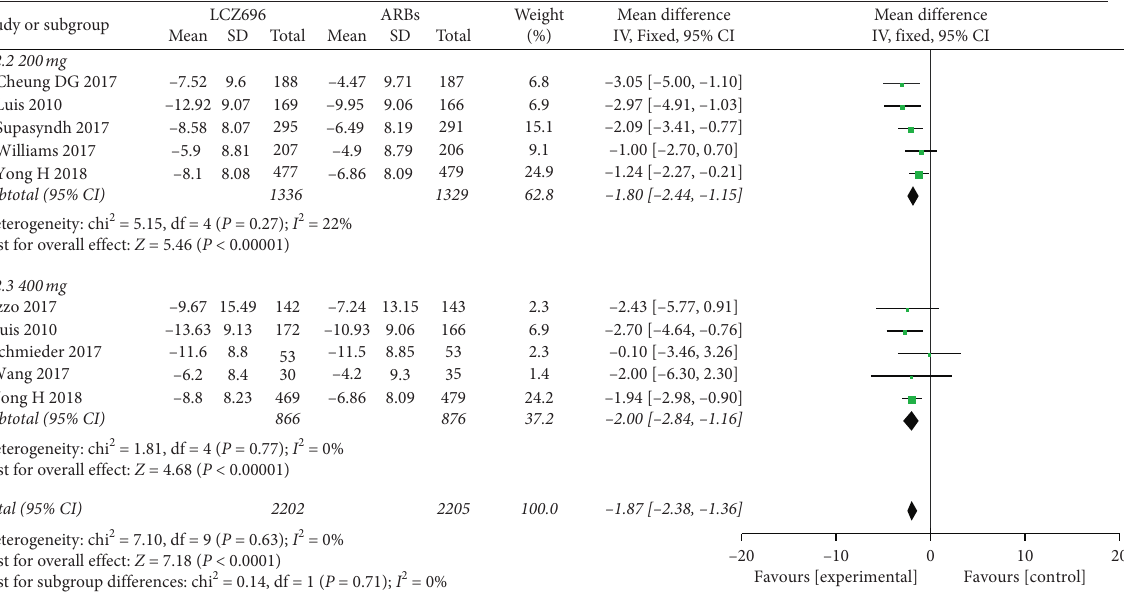
Figure 4: Comparison of LCZ696 with ARBs on mean reduction (mm Hg) in sitting diastolic blood pressure